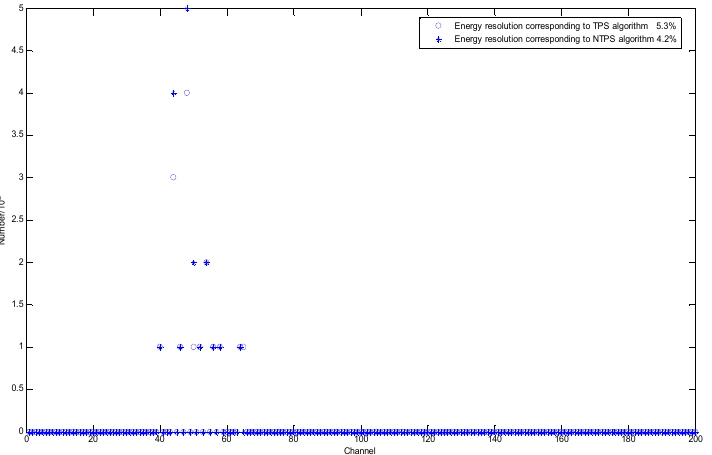
Figure 17. Comparison of the two algorithms in terms of energy resolution.